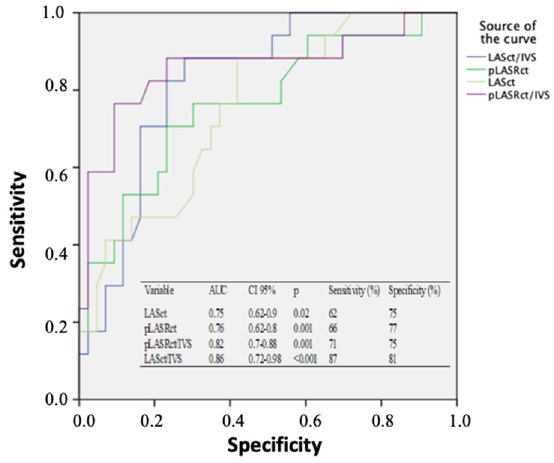
Figure 2. Receiver operating characteristic curves and the corresponding data for left-atrial me- chanical parameters to differentiate hypertrophic cardiomyopathy from arterial hypertension with left-ventricular hypertrophy. AUC, area under the curve; CI, confidence interval; IVS, interven- tricular septum; LASct, left-atrial strain during contractile phase; pLASTct peak strain rate during contractile phase. Table 3. Comparation of left-atrial (LA) strain parameters across HCM subjects with (G+) or with- out (G − ) pathogenic (P)/likely pathogenic (LP) variants and hypertensive subjects with left-ventric- ular hypertrophy (LVH).